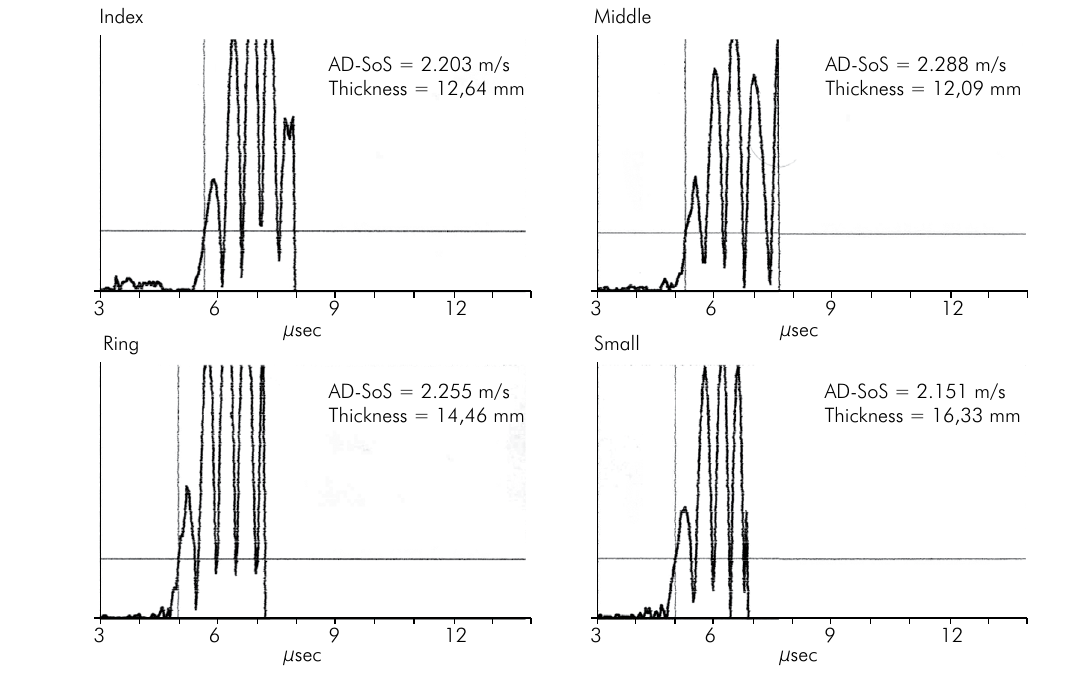
Figure 1. Biophysical bone profile of a control patient: presence of attenuation and inversion of the pulses compatible with age (74 years old). The value of AD-SoS > 2.040 m/s classifies the patient as having normal bone quantity; patient does not present bone fracture risk.